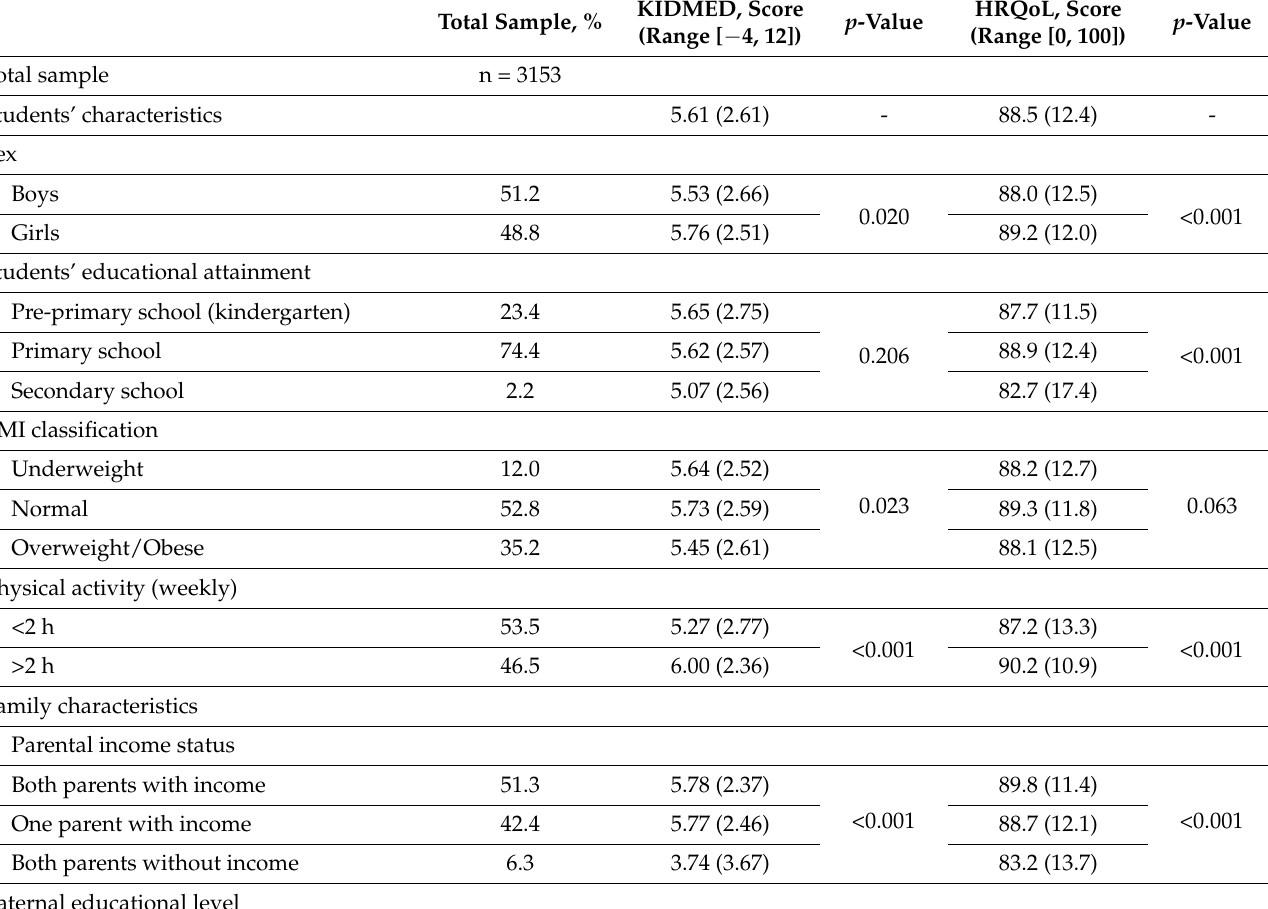
Table 1. Students’ level of adherence to the Mediterranean diet and parent-perceived quality-of- life measurements in students who participated in the DIATROFI Program according to students’ sociodemographic characteristics at baseline. Total Sample,